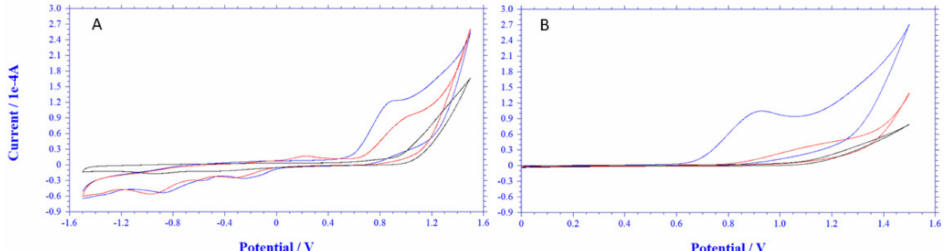
Figure 2. Current-potential curves of 5 mM of clenbuterol (blue line 1st cycle, red line 10th cycle) at a glassy carbon electrode in 20 mM of acetic acid/acetonitrile (55:45 v / v ) at pH 7.0 supporting electrolyte (black line). Scan rate: 100 mV.s − 1 . Potential range: ( A ) − 1.5/+1.5 V; ( B ) 0/+1.5 V.